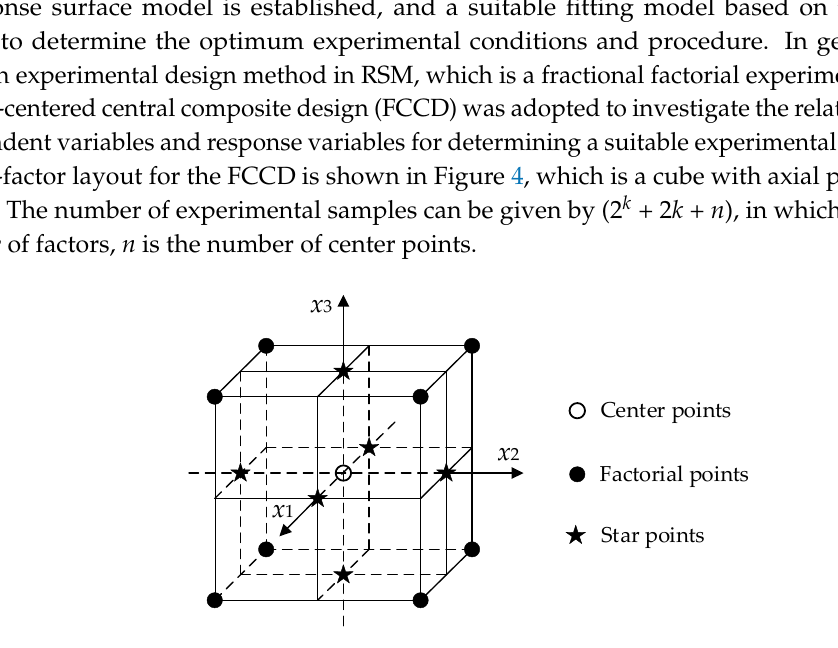
Figure 4. A three-factor layout for face-centered central composite design (FCCD).